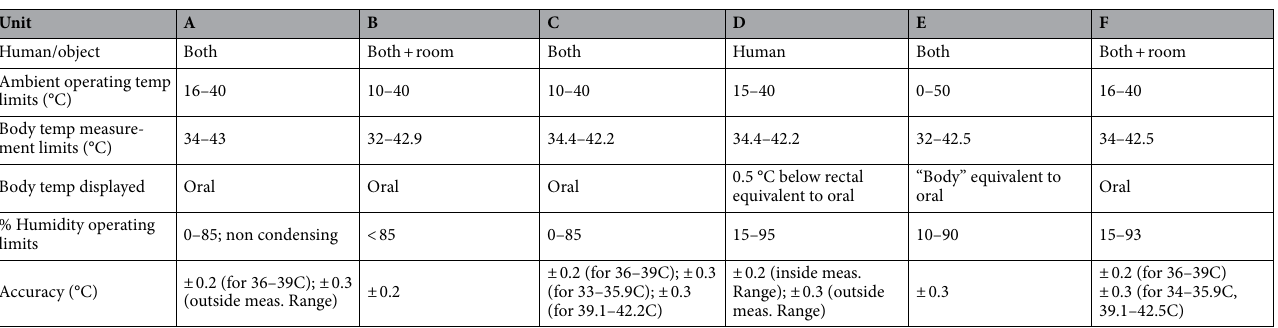
Table 1. Manufacturer’s specifications from instructions for